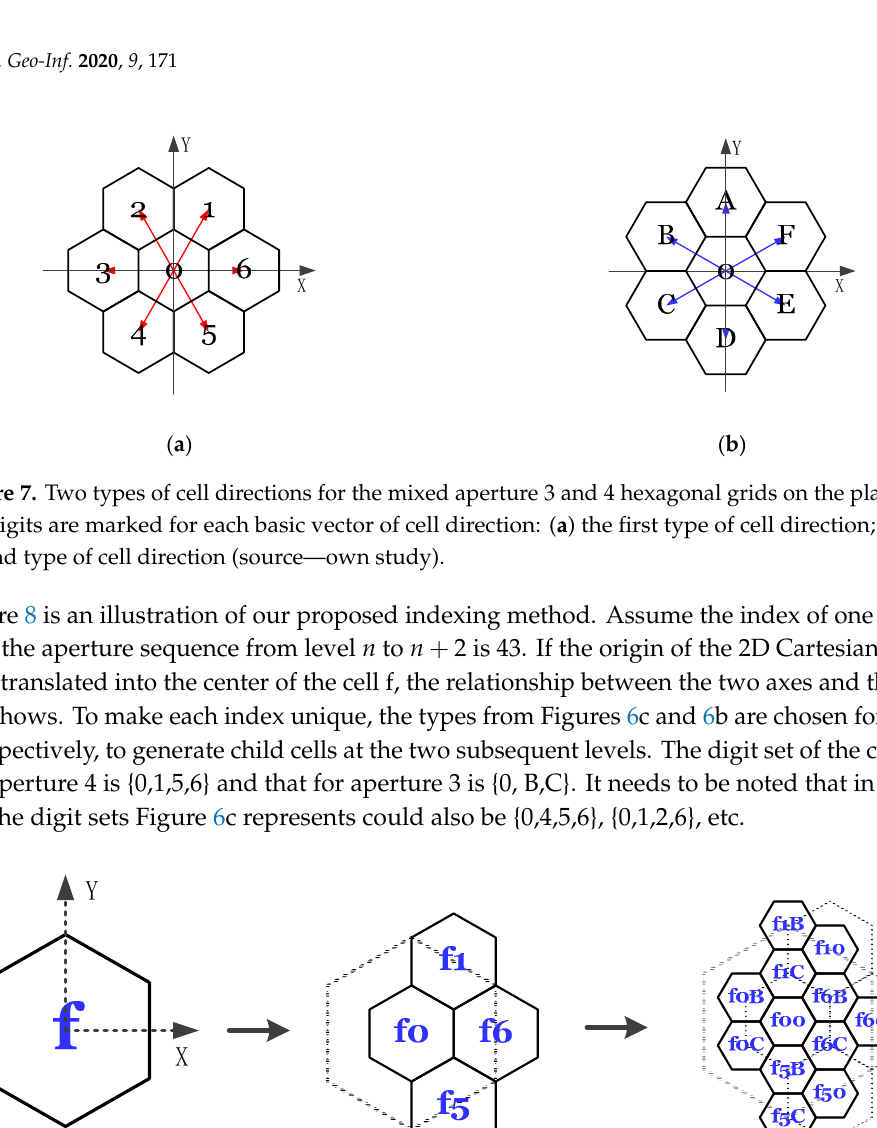
Figure 8. Diagram of the proposed hierarchy-based indexing method with aperture sequence 43 from level n to level n +2. The type of child cells for aperture 4 is from Figure 6c, and that for aperture 3 is from Figure 6b (source—own study).